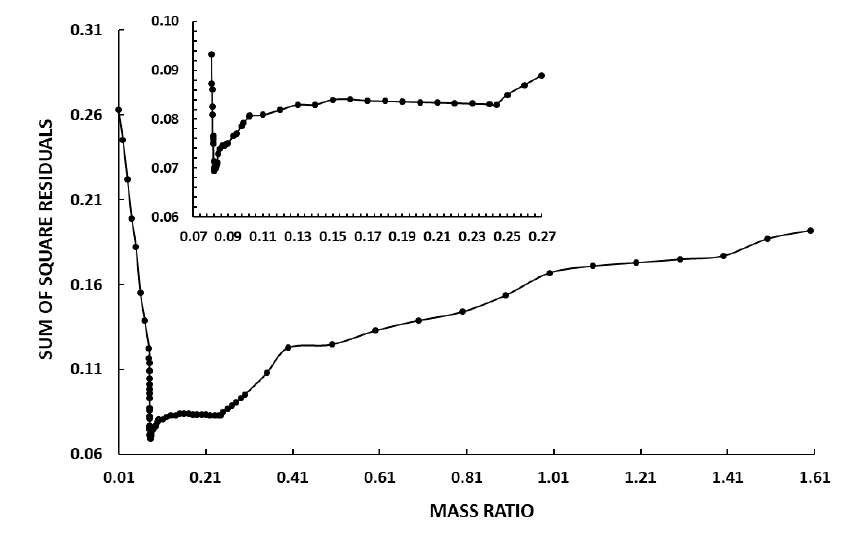
Fig. 3. Sum of the squared residuals as a function of the mass ratio. The minimum part is zoomed.